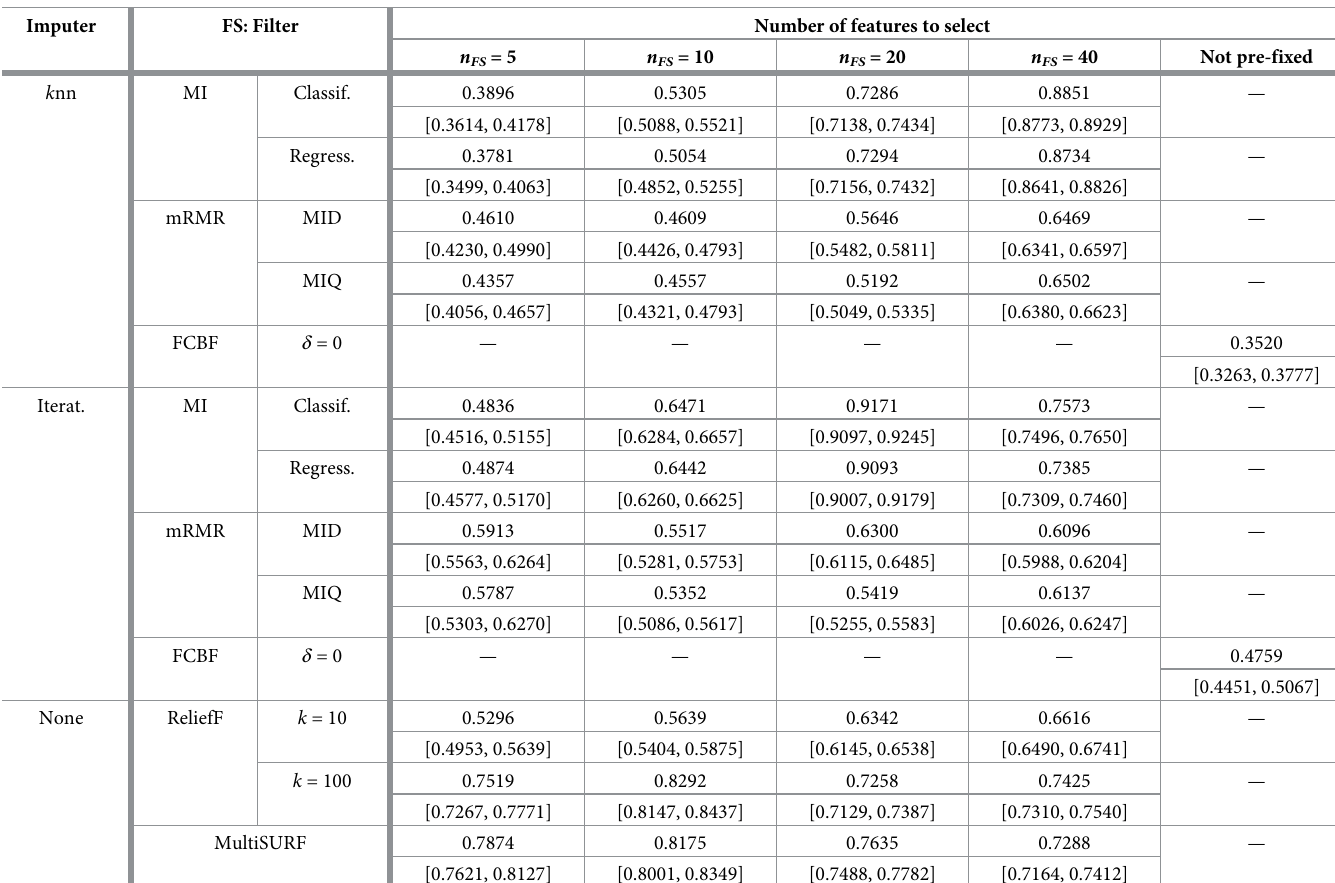
Table 2. Stability for the filter algorithms. Mean and 95%